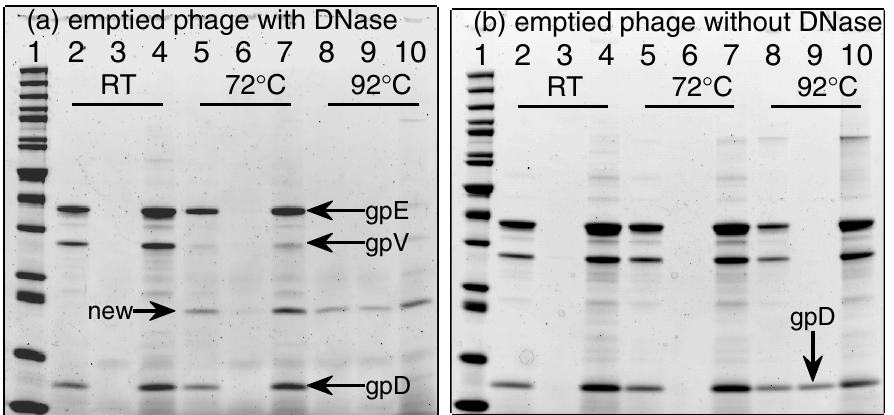
Figure 3. SDS-PAGE of emptied l phages incubated at room temperature (RT), 72, and 92 6 C. (a) With addition of DNase I. (b) Without the addition of DNase I. Gel conditions and lane annotations are as in Fig. 2.